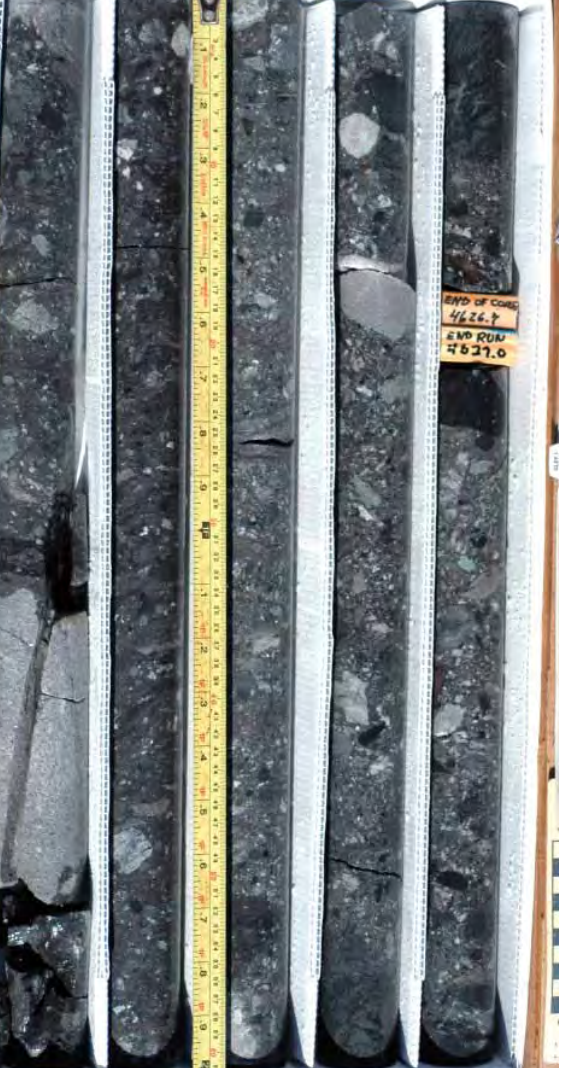
Fig. 1 and 2: courtesy of CBIS Deep Drilling Project Fig. 3 and 4: from David Powars, USGS